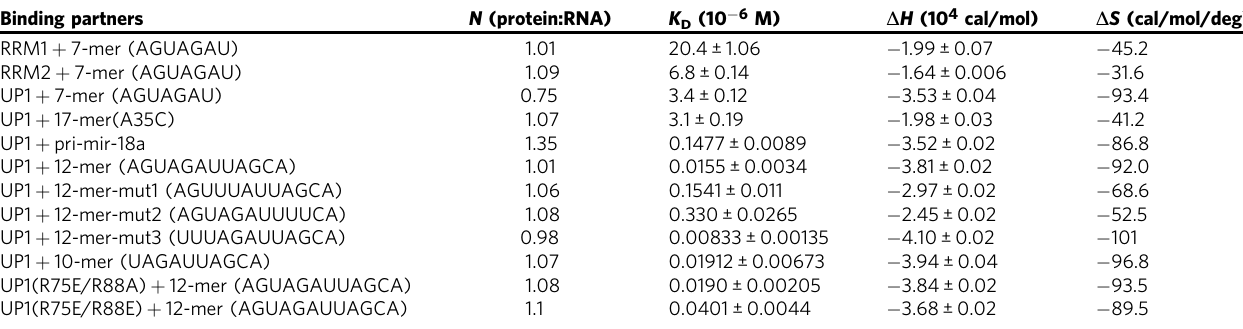
Table 1 Isothermal titration calorimetry of protein – RNA interactions Binding partners